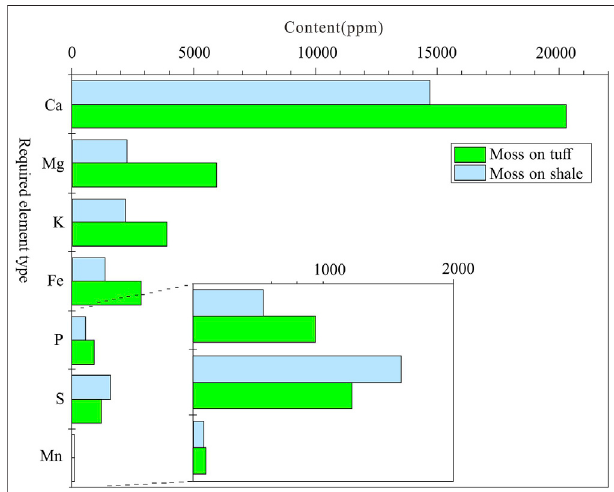
FIGURE 4 | Comparison of essential element content in the moss samples from the tuff layer and shale layers.